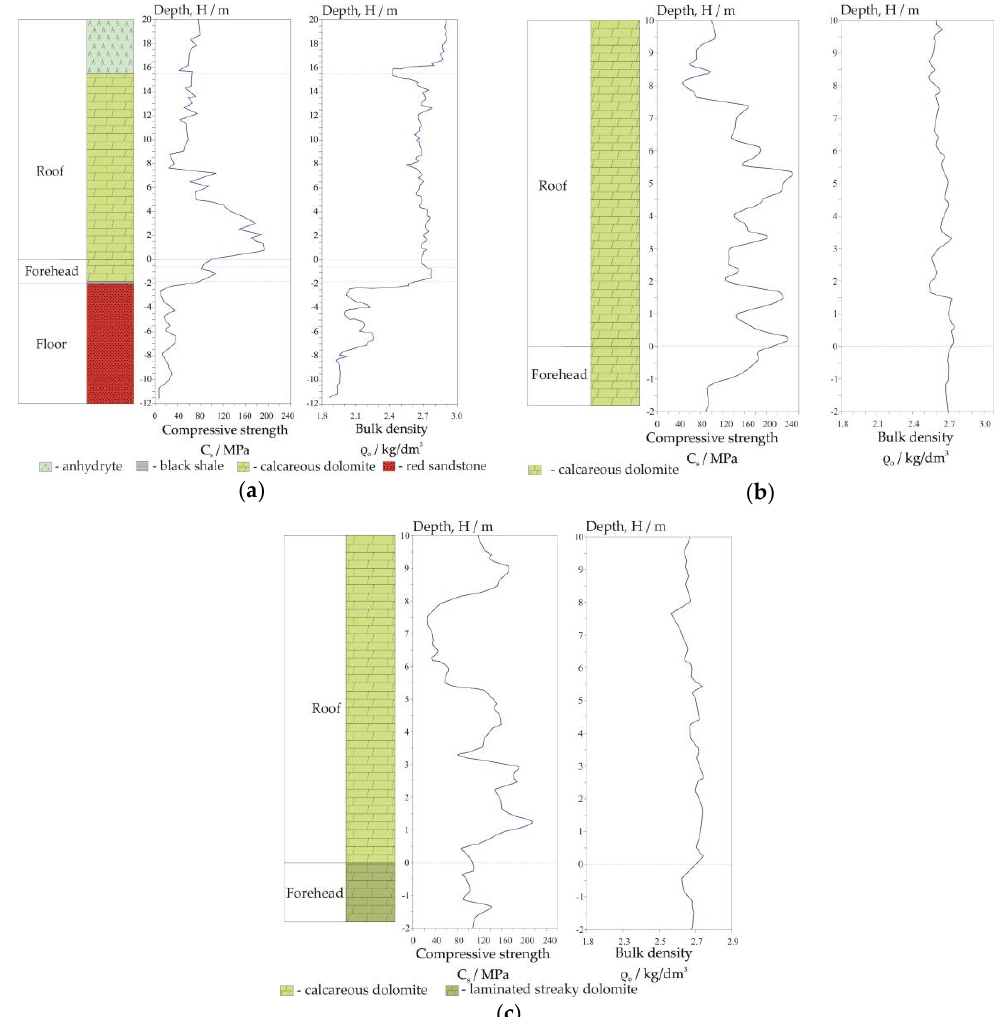
Figure 11 . Geotechnical profiles of the deposit in mining field B: (a) Drillhole G1; (b) Drillhole G2; (c) Figure 11. Geotechnical profiles of the deposit in mining field B: ( a ) Drillhole G1; ( b ) Drillhole G2; ( c ) Drillhole G3. Drillhole G3. Table 5. Geomechanical properties of rocks in the exploitation field